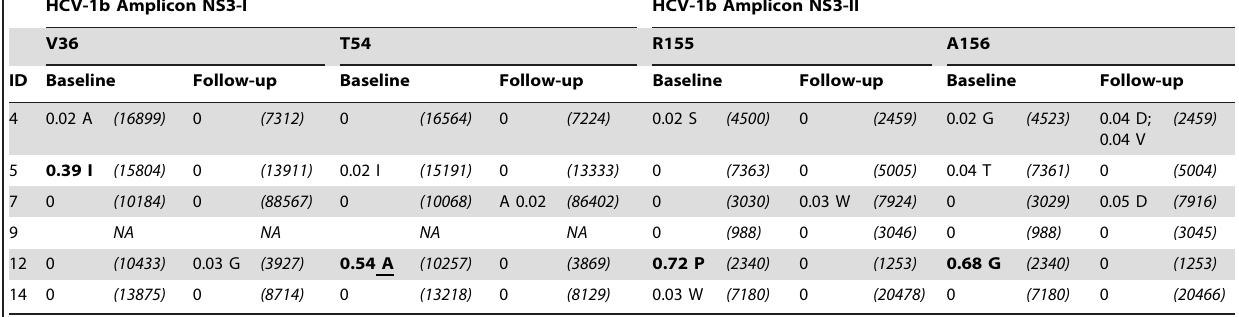
Table 4. HCV-1b NS3 UDPS mutation analysis.